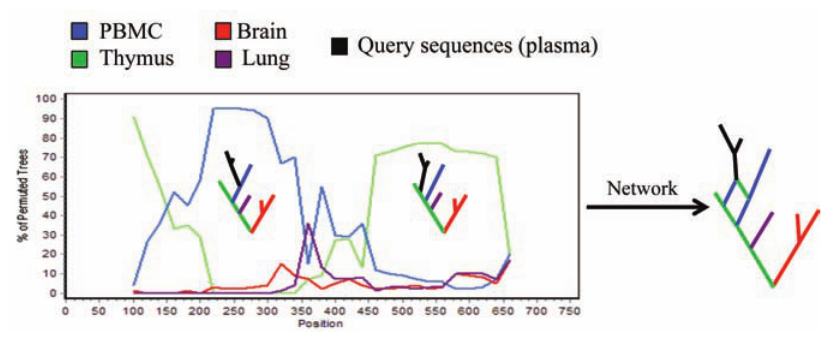
Figure 3. Putative recombination analysis of HIV-1 intra-host sequences sampled from different tissues as indicated by the color legend in the figure. A query sequence is com- pared to a set of reference sequences by a sliding window analysis, which calculates the bootstrap support for the clustering of the query sequence with a specific reference sequence along the genome. In this cartoon example, a query sequence from plasma clus- ters with high bootstrap support with a reference sequence from peripheral blood mononuclear cells (PBMCs) in the 5’ end of the genome, while with a sequence from thy- mus in the 3’ end. The two trees are schematically illustrated within the frame and the net- work shows how they could be represented by a cyclic graph where the recombinant sequence is simultaneously connected to the putative parental